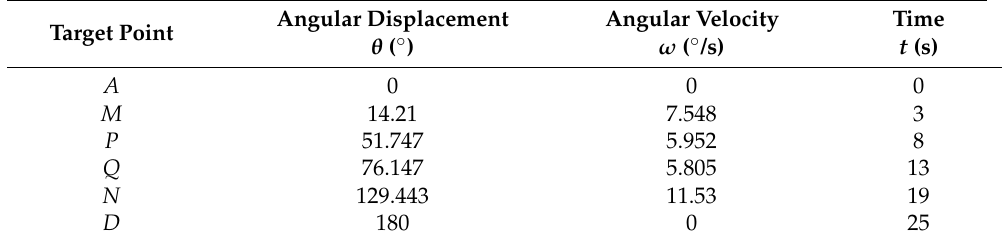
Table 2. Constraint conditions at newly-built targets points.